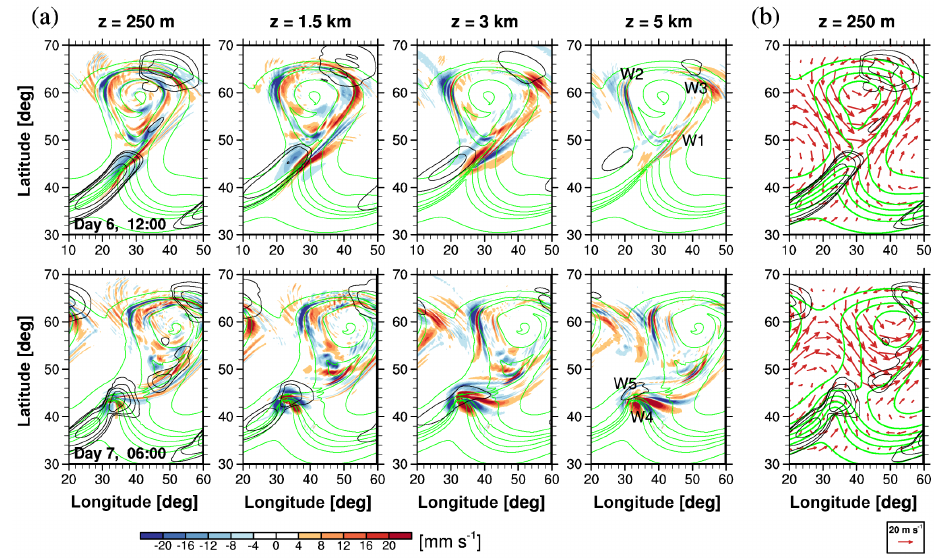
Figure 12. (a) w (cid:48) (shading) and frontogenesis function (FF, black) at z = 0 . 25, 1.5, 3, and 5km (from left to right) superimposed on the 250m total potential temperature (green) and (b) 250m background potential temperature (green) and horizontal wind (arrow) along with FF (black) at (upper) 12:00UTC on day 6 and (lower) 06:00UTC on day 7. w (cid:48) is multiplied by exp ( − z/ 2 H) . FF is plotted at values of 0.1, 0.3, 1, 3, and 10K 2 ( 100km ) − 2 h − 1 . The contour intervals for potential temperature and pressure are 8K and 8hPa,